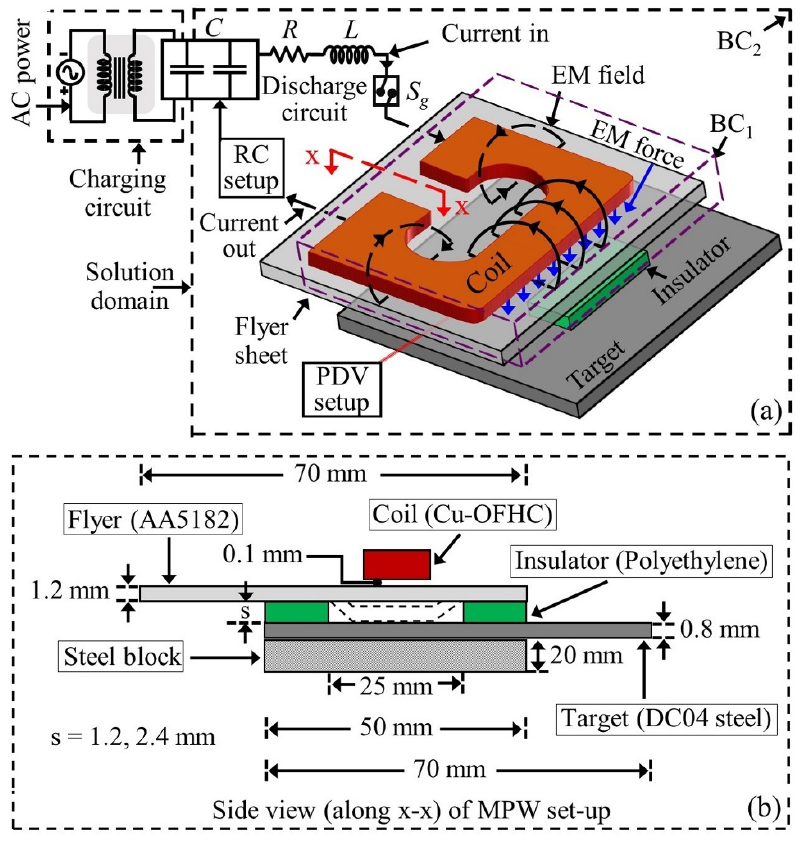
Figure 3. ( a ) MPW set-up with an O-shaped coil, and ( b ) a side view of the original joint assembly with the coil along the x-x section, shown in ( a ).